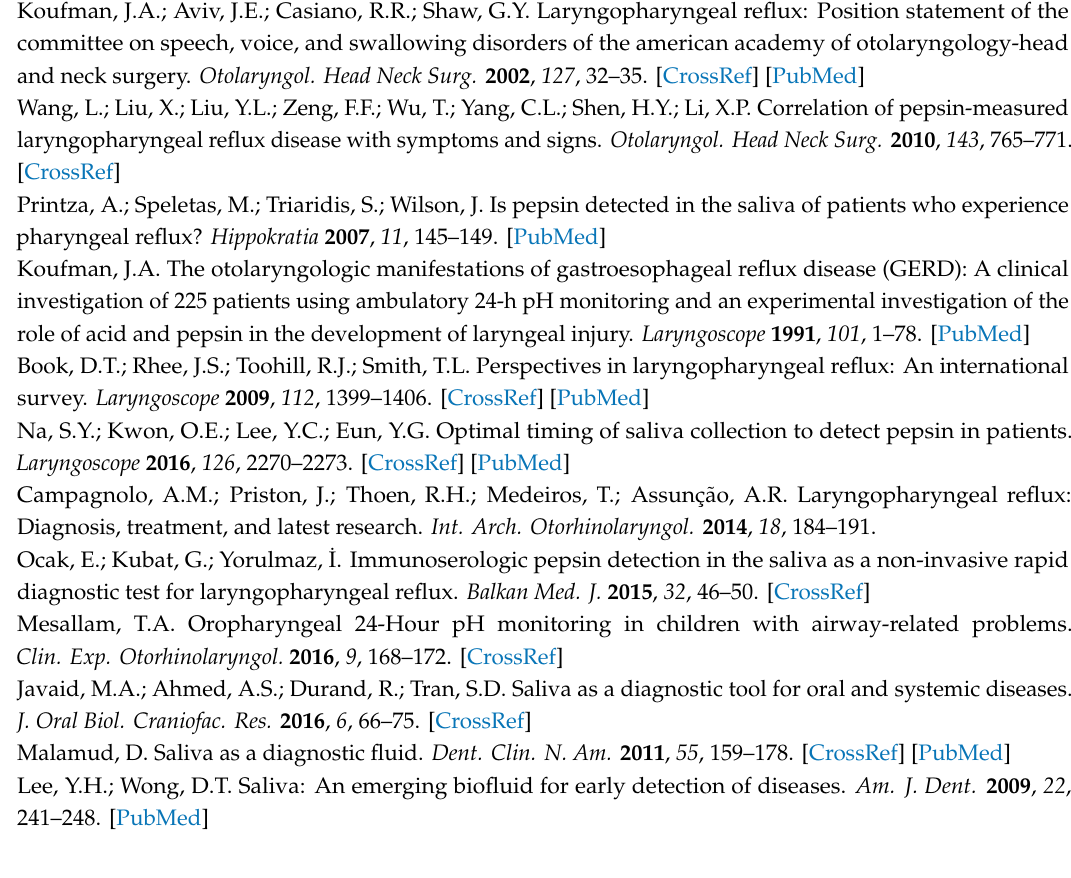
Figure S1: Schematic of the immunochromatographic pepsin